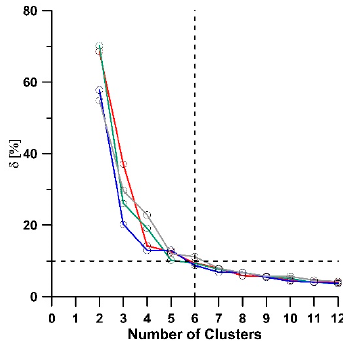
Figure 6. Percentage reduction ( δ ) of the total within-cluster sum of squares, relative to its previous value, as a function of the number of clusters. Here, for the clustering of the winter wind data objects, we observe that from 6 clusters on, the reduction δ is less than 10% each unit step in the increase of the number of clusters: 0% ≤ δ ≤